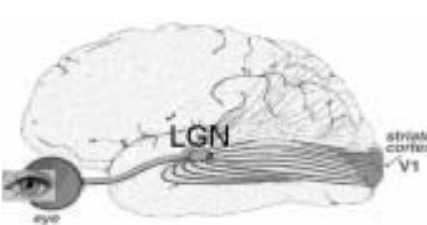
Figure 3 Eye, LGN,